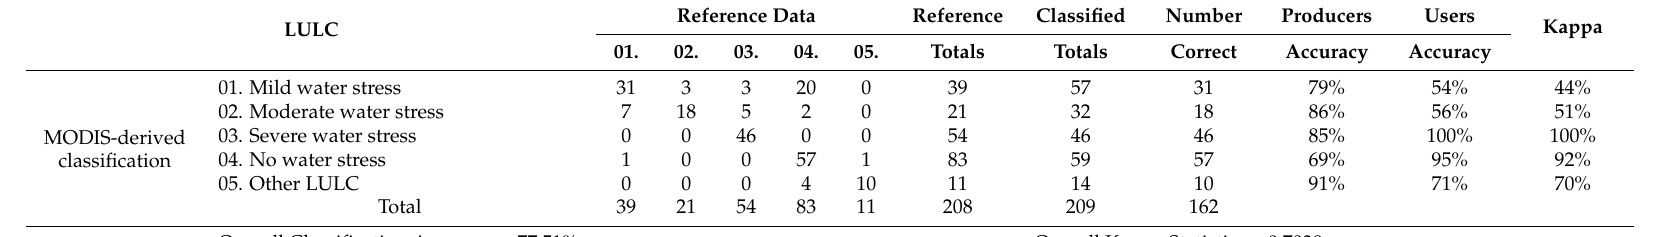
Table 7. Accuracy assessments done using error matrix for water stress classes of 2015–2016.